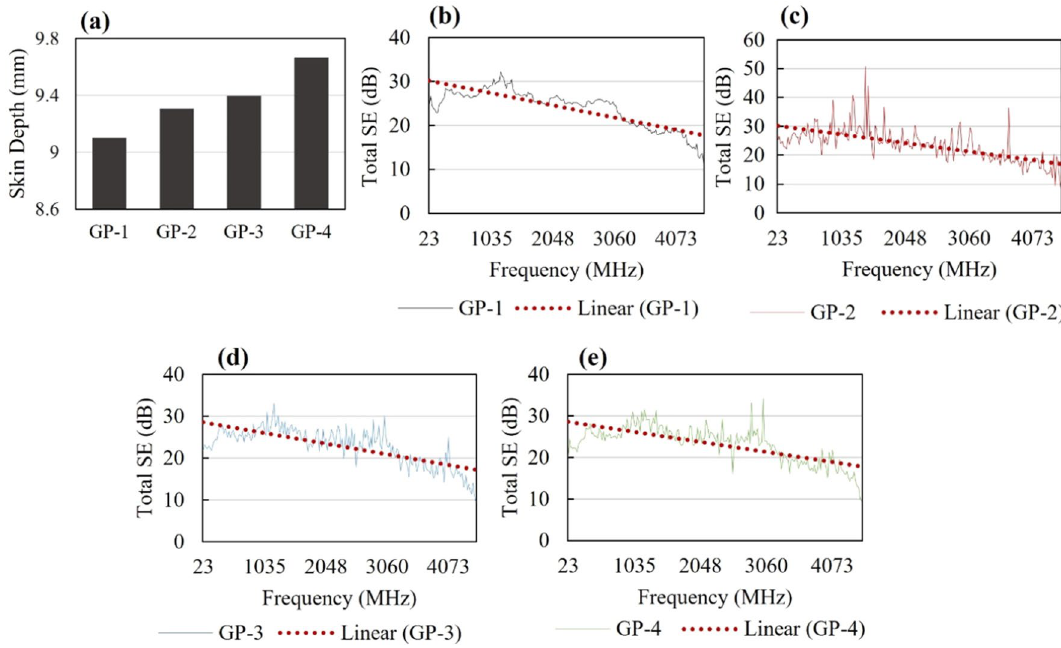
Figure 13. Total EMI-SE of geopolymer samples with 10 mm thickness ( a ) GP-1, ( b ) GP-2, ( c ) GP-3 and ( d )